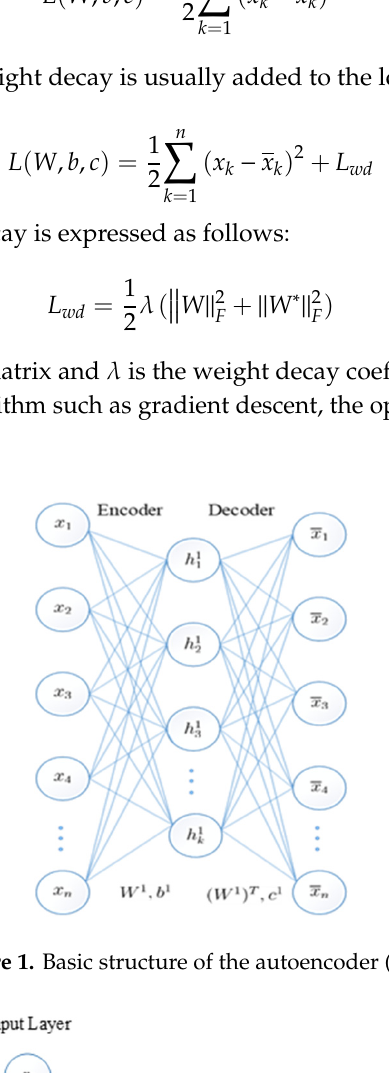
Figure 2. Stacked autoencoder (SAE) structure. The SAE is an unsupervised neural network model whose core function is to learn the deep representation of input data. The input layer data x is converted to its hidden layer representation and then reconstructed by the hidden layer to restore new input data. The training goal of the SAE is to make the reconstructed data restore the input layer data as much as possible. The loss function of the SAE is usually defined by mean square error, as shown in Equation (3): = =